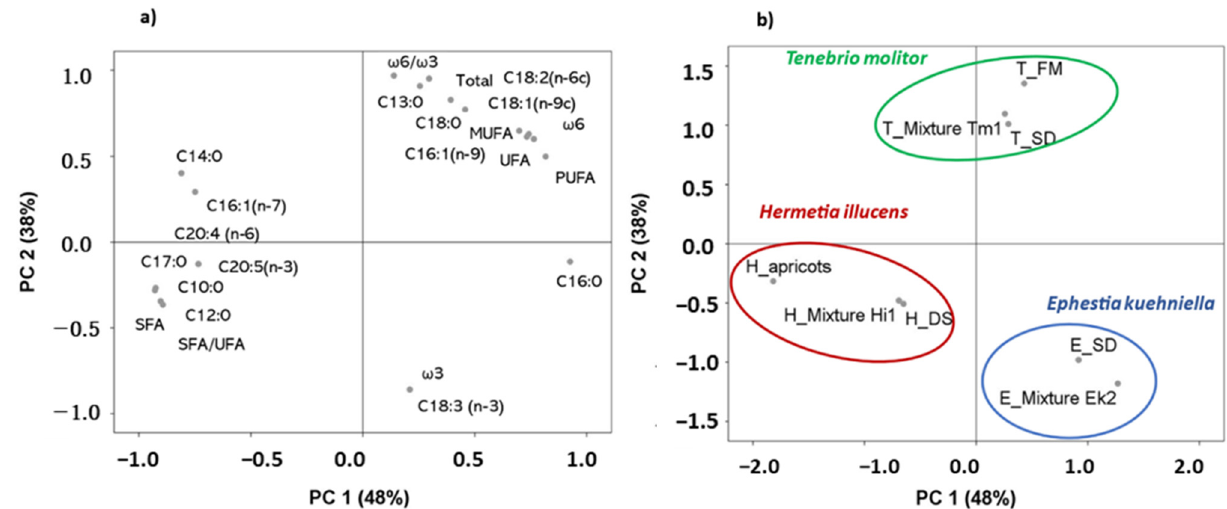
Figure 1. Scattering the data of fatty acids and lipid indices by the first two principal components (PC1 and PC2): analysis of different insect species fed different diets. ( a ) Biplot of the first two components created considering fatty acids and lipid indices; ( b ) rotated principal scores of insect species and their corresponding diets projected onto the first two principal